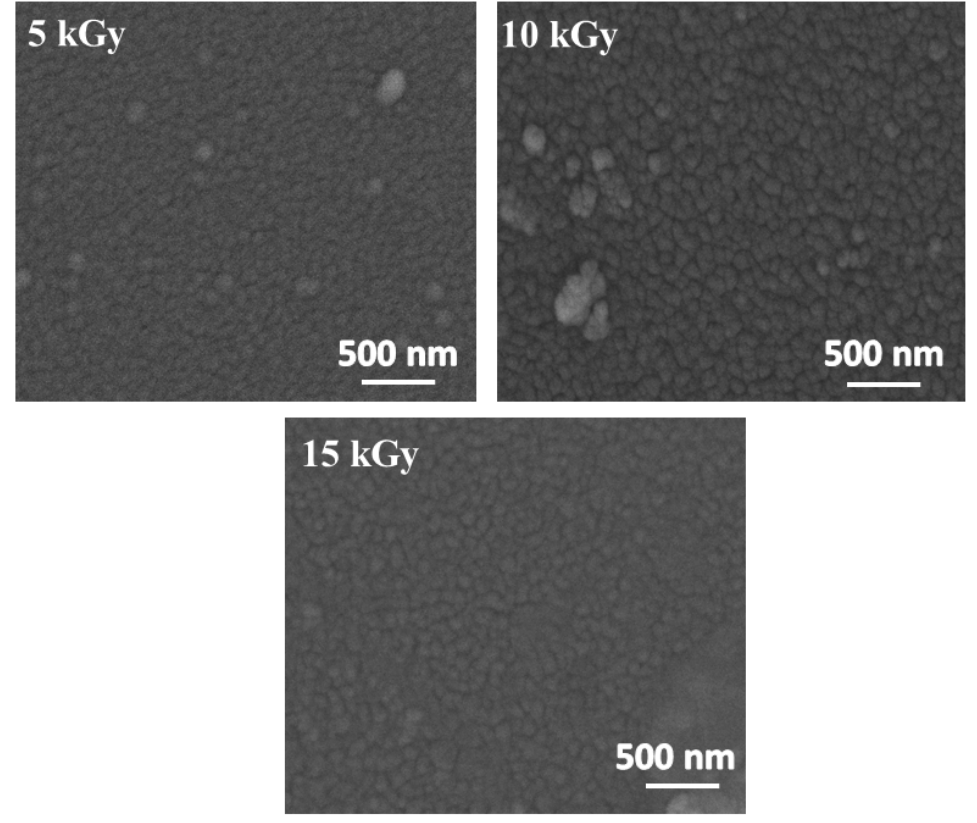
Figure 3. SEM images of irradiated IZO thin films.